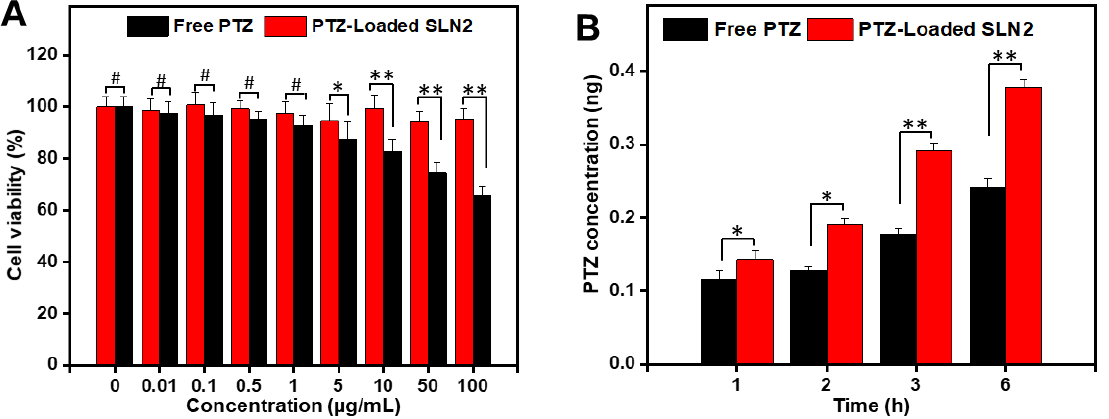
Figure 5. Evaluation of cytotoxicity and cellular permeation in Caco-2 cells. ( A ) Cellular cytotoxicity by MTT assay; PTZ-loaded SLN2 or free PTZ (used as control) were incubated with Caco-2 cells for 48 h, at the indicated concentrations (0 – 100 µg/mL); ( B ) transcellular transport/permeability of PTZ. Caco-2 cells were incubated with PTZ-loaded SLN2 (5 µg PTZ) or free PTZ (used as control) for different indicated times. Data are expressed as mean ± SD (n = 3). # p > 0.05 shows insignificant differences, whereas * p < 0.05, ** p < 0.01 are considered mild and moderate statistical significance, respectively.